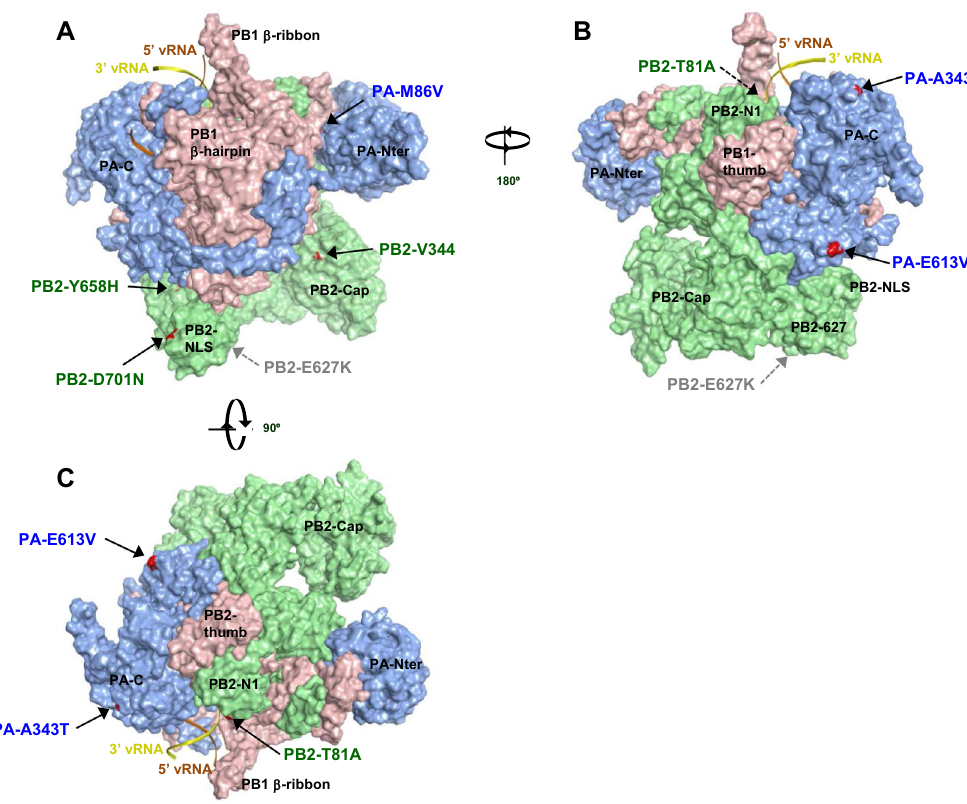
Figure 7. Structural model of the VN/HN polymerase complex. Structural model of the VN/HN heterotrimeric polymerase complex bound to the vRNA promoter. ( A – C ) Surface view of the EG/D1 structure is color-coded showing PB2 (green), PB1 (pink), PA (blue) and the mutations in this study (red). Structures in ( A ) and ( B ) differ by 180° in orientation, and structures in ( A ) and ( C ) differ by 90° in